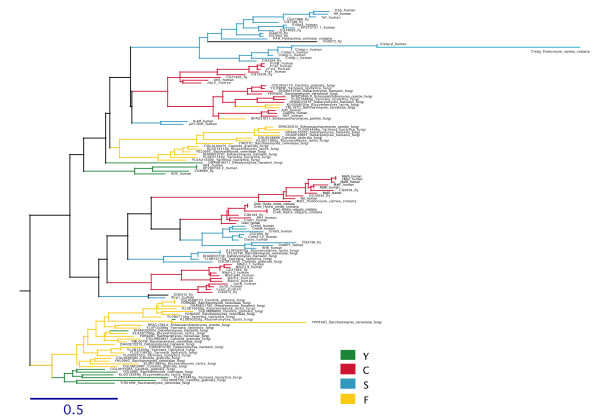
Neighbour joining tree of the Basic region of human, fly, cnidarian and fungal bZIPs. The colouring of the clades is based on the amino acid at position 19 (green – tyrosine; red – cysteine; blue – serine; yellow – phenylalanine).